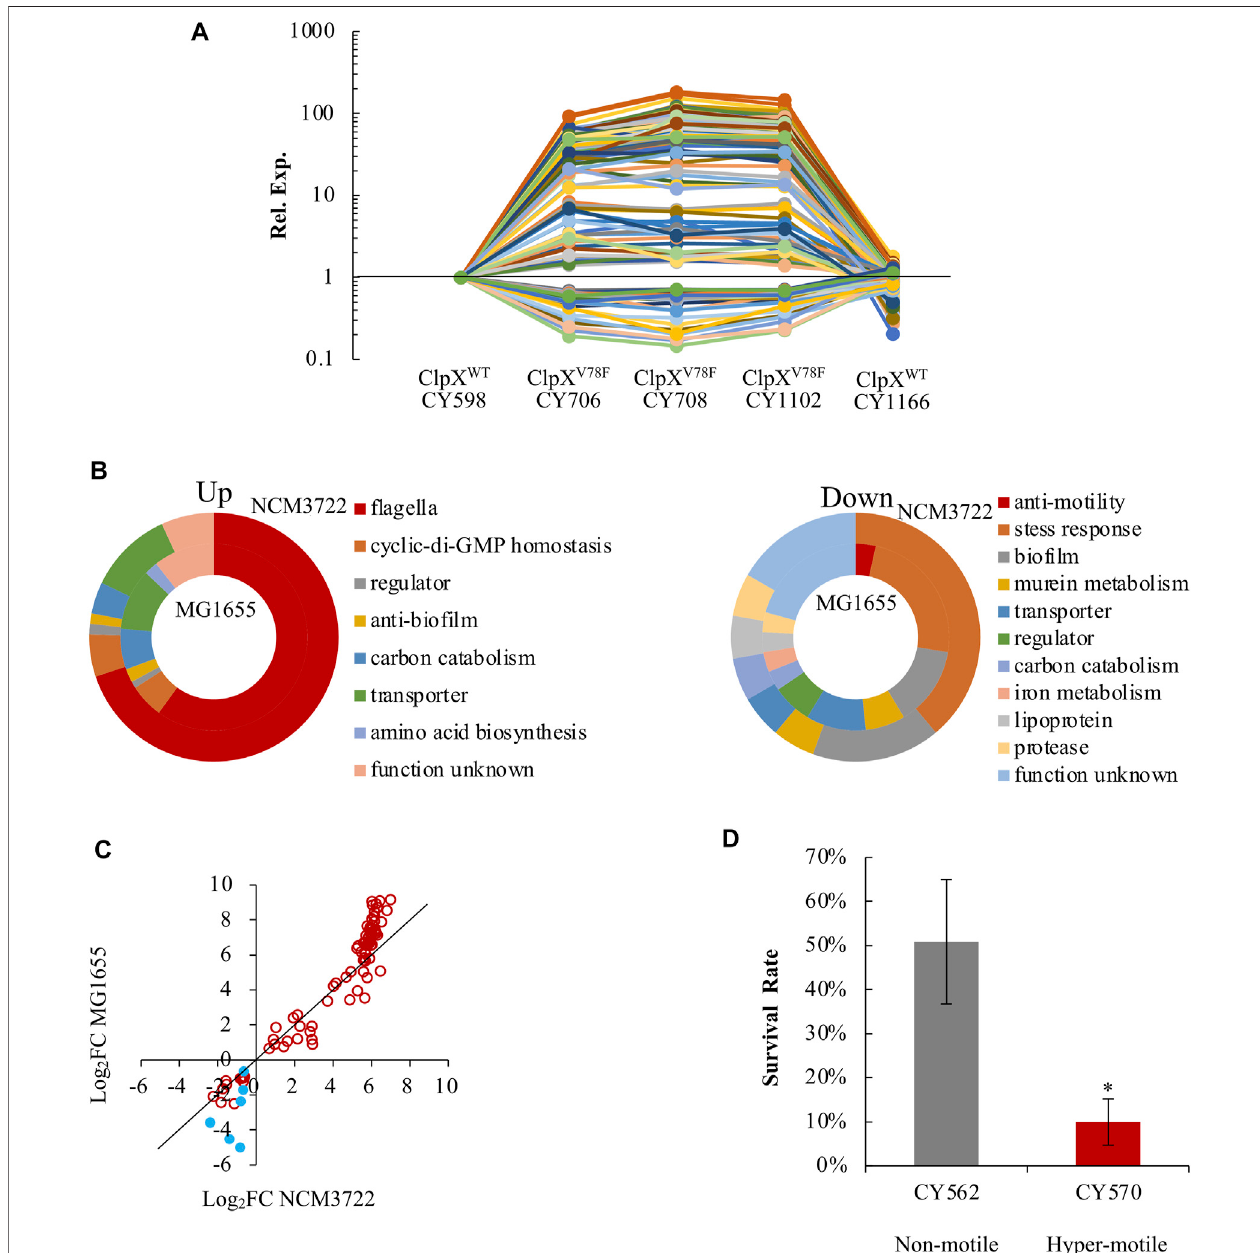
FIGURE6| E.coli reprogramsits global geneexpression whenchangingfrom non(weak)-motiletohypermotile status. (A) Theexpression trendsofthe 114DEGs among the hypermotile strains (CY706, CY708, CY1102) and weak-motile strains (CY598, CY1166). See Supplementary Table S1 . The expression of each gene in CY598 was normalized to 1, and that in other strains was determined relative to this value. The relative expression is shown as the average of the three independent RNAseq assays. (B) Diagrams grouping the upregulated genes (upper) and downregulated genes (lower) obtained between the hypermotile strains versus the non(weak)-motile strains by the known functions of their gene products. The percentage of the genes ’ number in each functional group is shown. See Supplementary Table S1 . The results obtained in the NCM3722 and MG1655 background are, respectively, shown in the outer and inner doughnut charts. (C) The fold change (FC) of the expression of the 91 genes between the hypermotile and non(weak)-motile strains in NCM3722 background was plotted against that in MG1655 background. The data were shown as Log 2 FC. Genes encoding known stress-response factors were highlighted as blue solid circles. To guide eyes, the black line is shown as y (cid:1) x. (D) The survival rate of non-motile and hypermotile MG1655 strains after 5-min challenge of pH 2.5. The survival rate is shown as the average ± S.E.M. of the three independent experiments. * p ≤ 0.05 versus the survival rate of CY598.